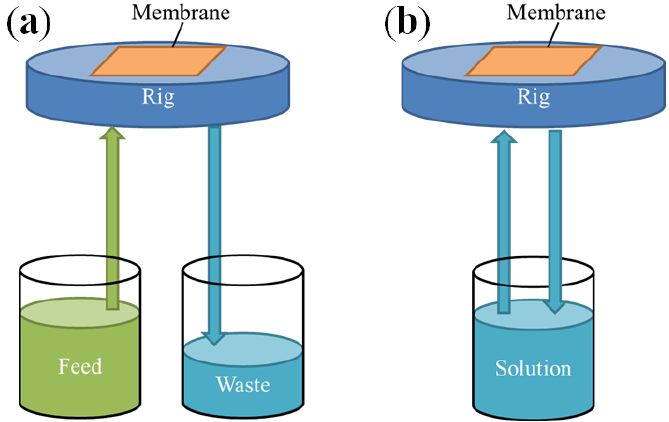
Figure 7. Schematic of the cross-flow contact rig: ( a ) non-recirculated flow; and ( b ) reference recirculated solution